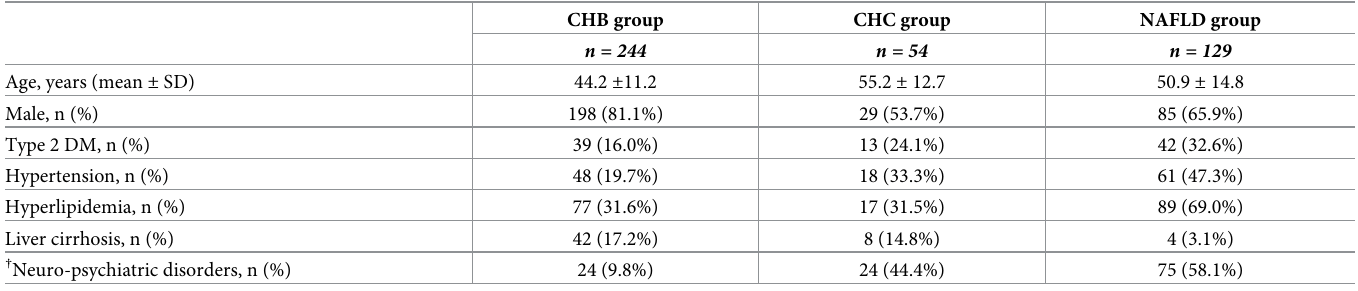
(p = 0.001), particularly in the items of PF (mean = 81.6 ± 16.3) and BP (mean = 75.7 ± 23.0) (Table 2). There was no significant difference between CHB and NAFLD patient groups in the PCS scores. In the MCS of the SF-36 survey, NAFLD patient groups had a significant lower MH score (mean = 63.2 ± 13.8) than CHB and CHC patient groups (p = 0.019) (Table 2). There was no significant difference in MCS scores between 3 groups. Comparison of mean scores of eight realms between groups are demonstrated as error bars in Fig 1, and respective summary scores in Fig 2. The correlation between disease severity and HRQoL The FIB-4 index scores in CHB and CHC were 2.76 ± 3.44, and 2.89 ± 2.98, respectively. The scores of CHB and CHC patient groups were significantly higher than NAFLD patients (1.51 ± 1.09) (p < 0.001). Patients were divided into three groups by FIB-4 index scores, respectively FIB-4 score < 1.45, FIB-4 score between 1.45 and 3.25, and FIB-4 score > 3.25. Mean scores were